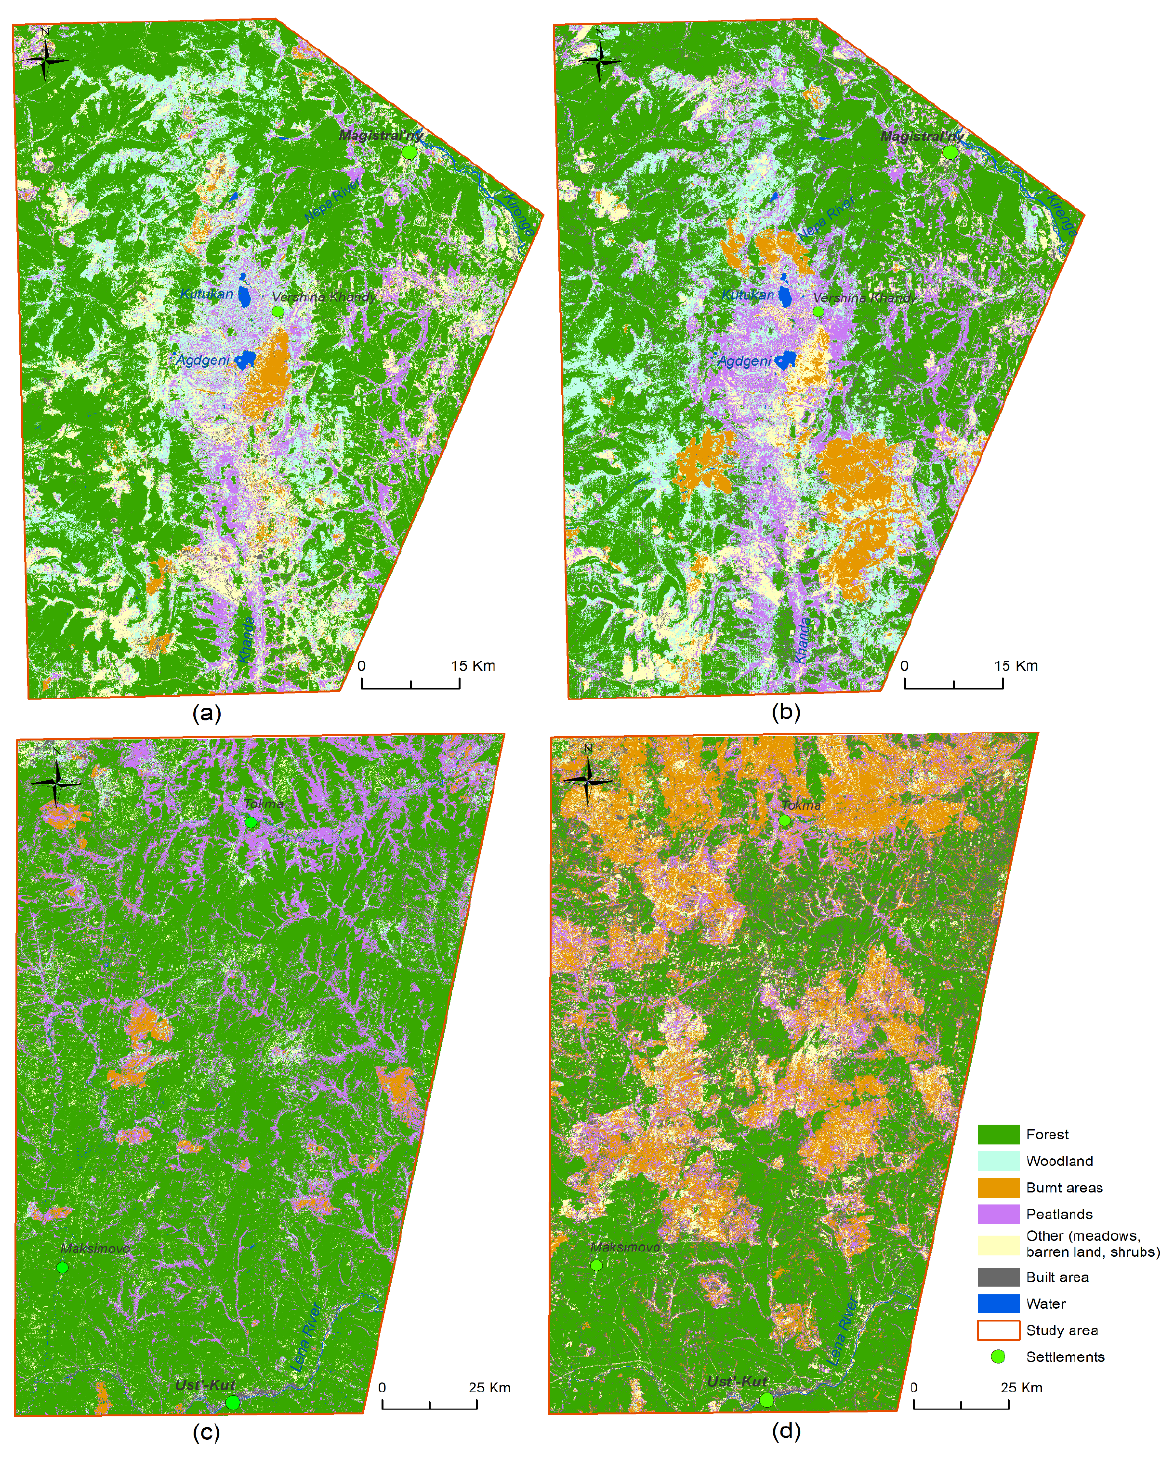
Figure 5. Types of land cover in the study areas: ( a )—Khanda area, 2014; ( b )—Khanda area, 2019; ( c )—Tokma area, 2014; ( d )—Tokma area, 2019.